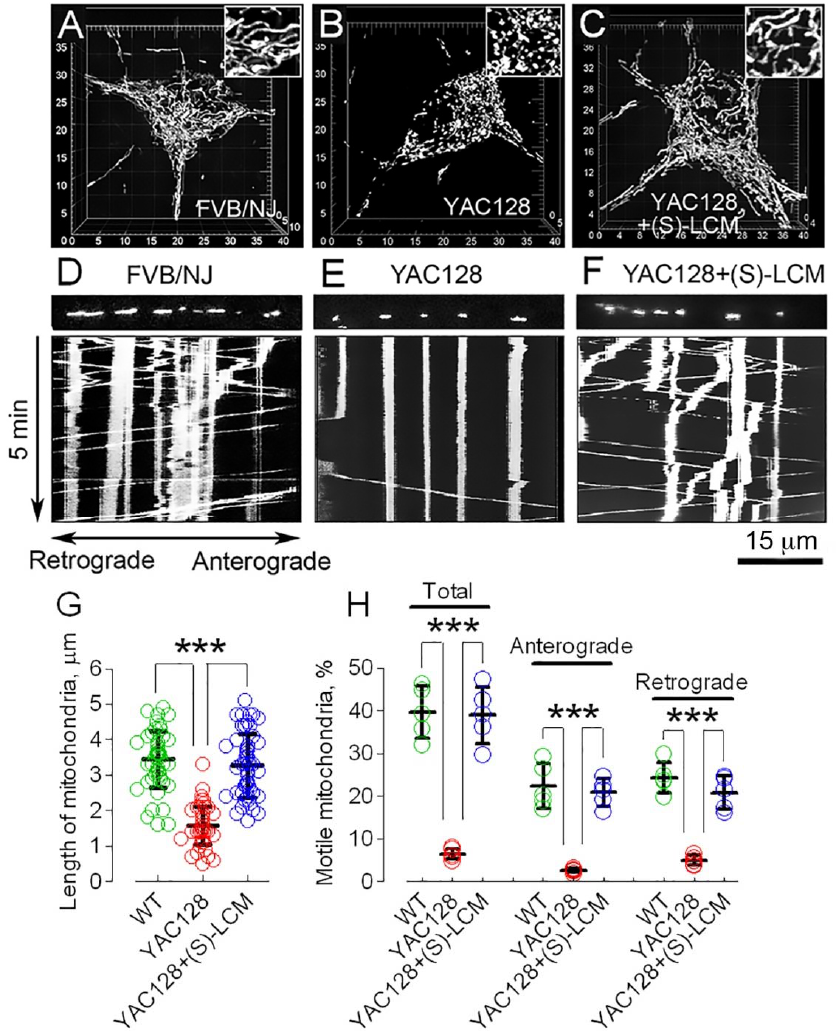
Figure 5. An increase in mitochondrial fission ( A – C , G ) and suppressed mitochondrial motility ( D – F , H ) in cultured striatal neurons (10 DIV) from FVB/NJ mice (wild-type, WT) compared to striatal neurons from YAC128 mice. (S)-lacosamide ((S)-LCM) rescued mitochondrial morphology and motility ( C , F – H ). Mitochondria were visualized by expression of mitochondrially targeted enhanced yellow fluorescent protein (mito-eYFP). ( A ), 3D image shows normal, elongated mitochondria in neuron from wild-type FVB/NJ mouse. ( B ), increased fission in neuron from YAC128 mouse. ( C ), preservation of mitochondrial morphology in YAC128 neuron treated with 10 µ M of (S)-LCM for the last 7 days prior to imaging. In Insets , mitochondria are shown at additional 2 × magnification. In ( D , E ), suppressed mitochondrial traffic in cultured striatal neurons from YAC128 mice are compared with neuron from FVB/NJ mouse (WT). ( F ), (S)-LCM rescues mitochondrial motility in neuron from YAC128 mouse. Cells were treated with 10 µ M of (S)-LCM for the last 7 days prior to analysis. ( G ), length of mitochondria in µ m. One hundred randomly chosen mitochondria from